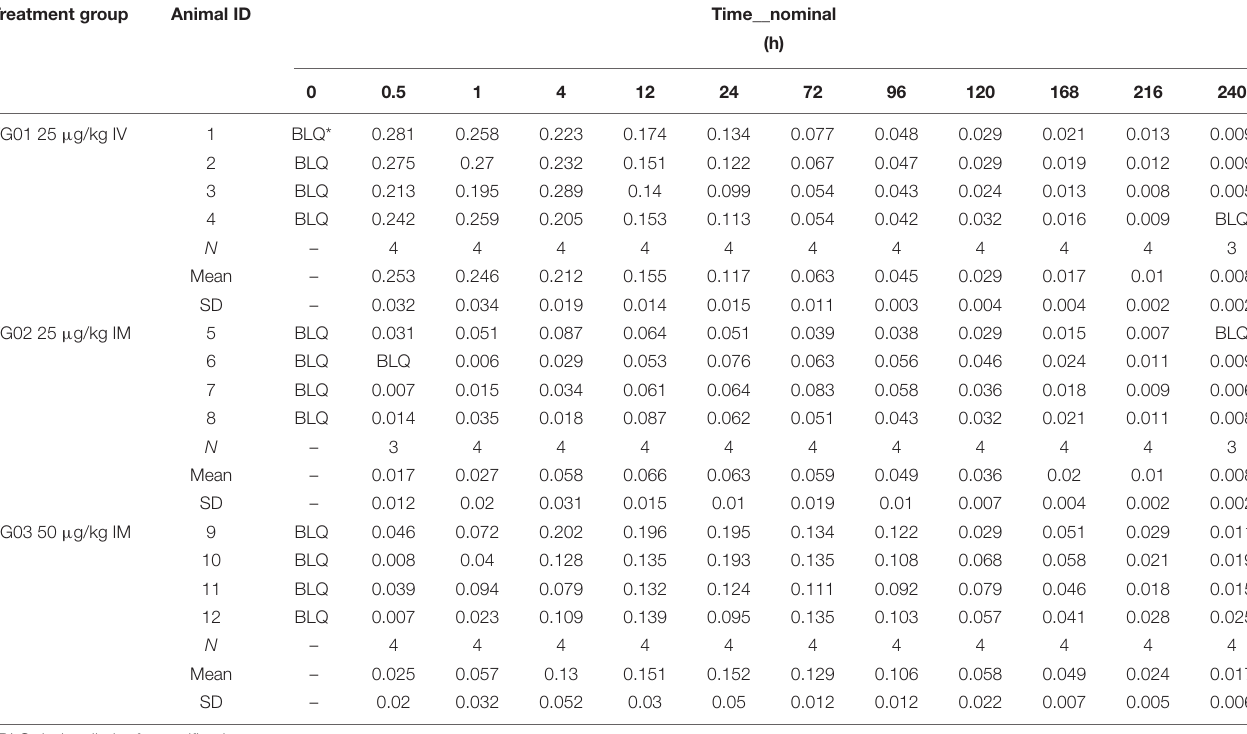
TABLE 1 | Individual and mean plasma concentration ( µ g/ml) of PEGpoIFN α . Treatment group